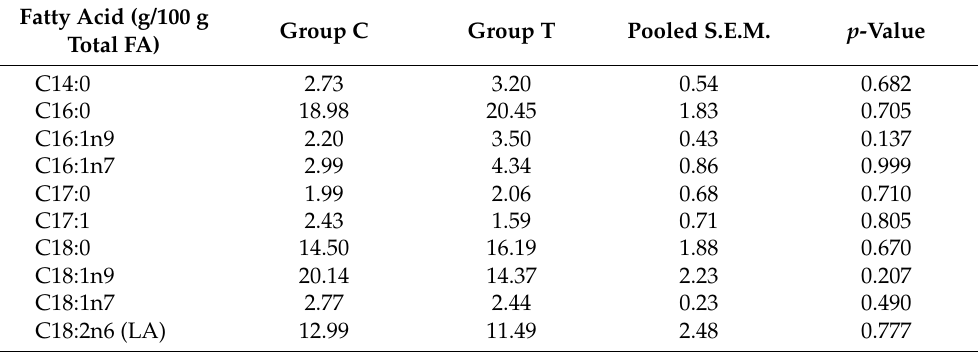
Table 1. Fatty acid composition of the plasma at day 100 of gestation of control gilts (group C) or gilts treated with hydroxytyrosol and n3-PUFA from day 35 to day 100 of gestation (group